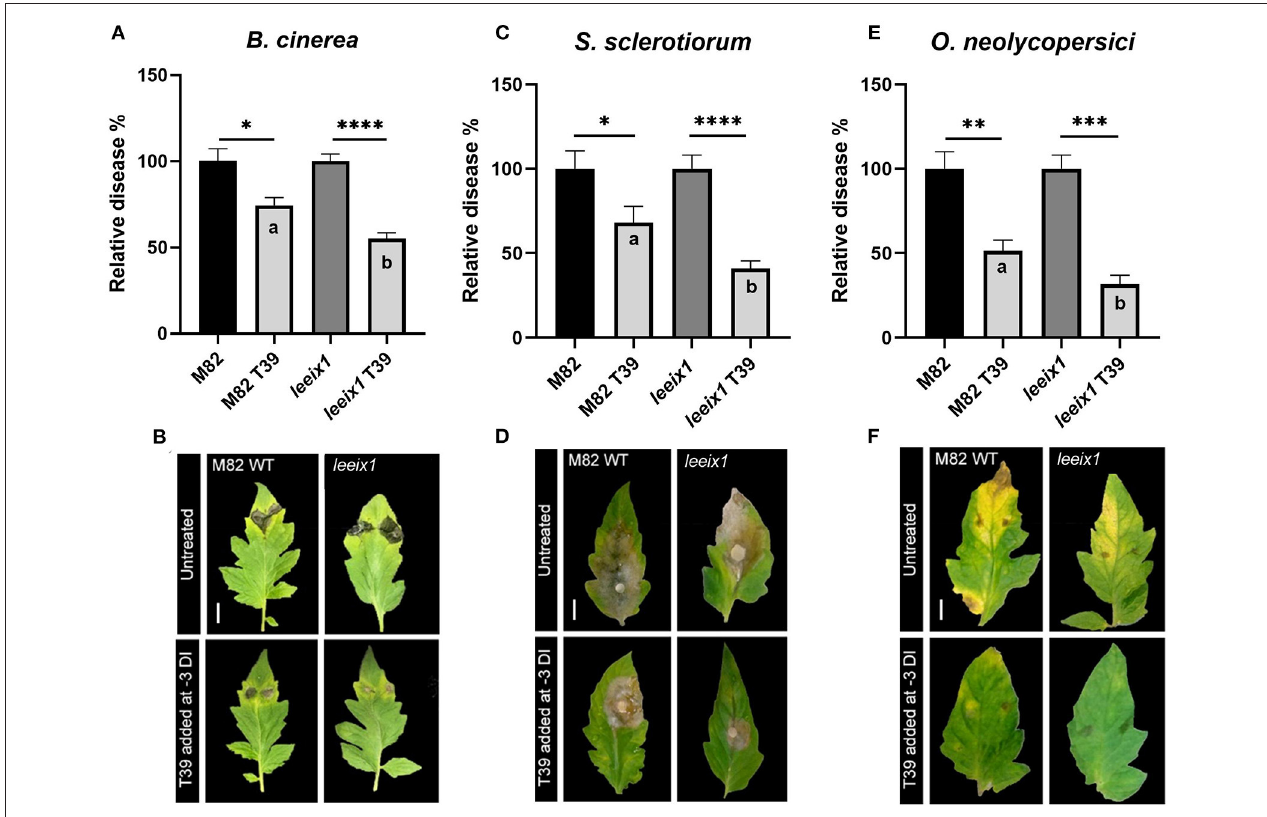
FIGURE 3 | leeix1 mutants have improved disease resistance in response to T. harzianum T39. WT M82 and leeix1 plants were challenged with B. cinerea (10 6 spores /mL) (A,B) , S. sclerotiorum (mycelial plugs from 5 day old plates) (C,D) , and O. neolycopersici (10 4 conidia /mL) (E,F) . Relative disease area was calculated as the lesion area measured 5 days after inoculation in each genotype treated with T39 as compared to mock-treated controls for B. cinerea and S. sclerotiorum , and similarly, 10 days after inoculation, for O. neolycopersici . (B,D,F) representative images taken on day of measurement. (A) Average ± SEM of 6 independent replicates is shown, N = 85. (C) Average ± SEM of 3 independent replicates is shown, N = 20. (E) Average ± SEM of 3 independent replicates is shown, N = 12. In all cases, asterisks represent statistical significance of T39 treatment over control in a one way analysis of variance with a Bonferroni post-hoc test, p < 0.0165, and letters represent statistical significance between the WT and leeix1 T39 treated samples in a one way analysis of variance with a Bonferroni post-hoc test, p < 0.03.